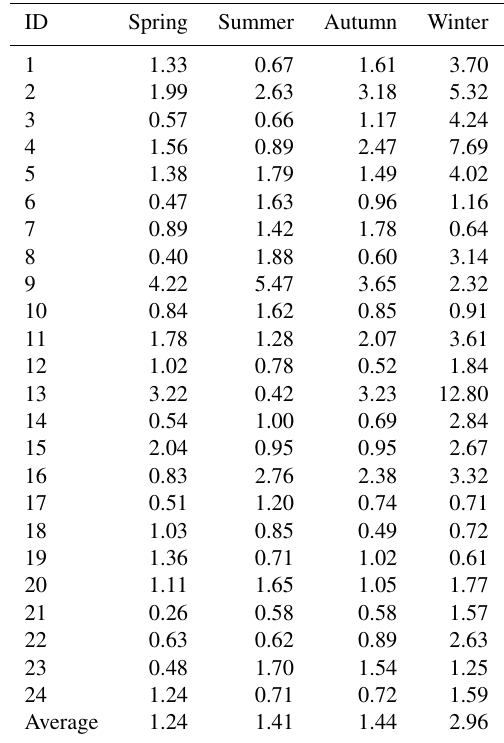
Table 5. RMSEs of seasonal temperatures between the original ERA-Interim and corrections for the 24 sites in 1979–2013. ID